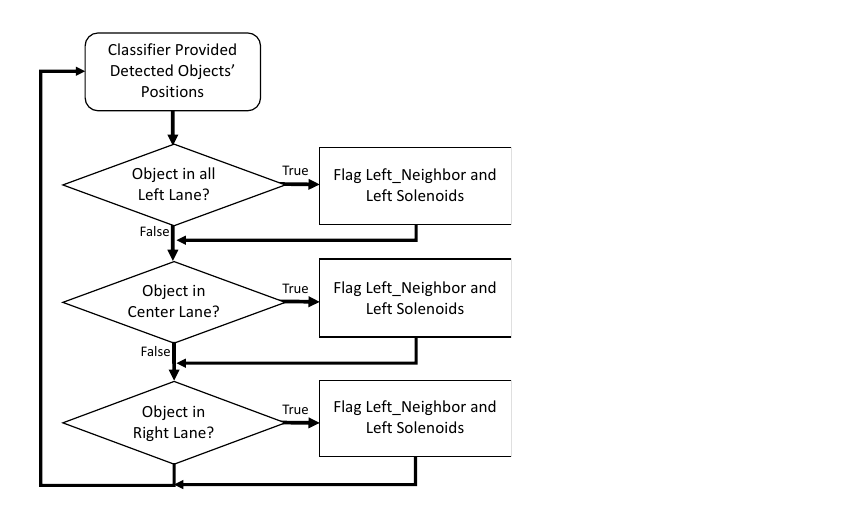
Figure 14. The flow chart for the solenoid firing loop.